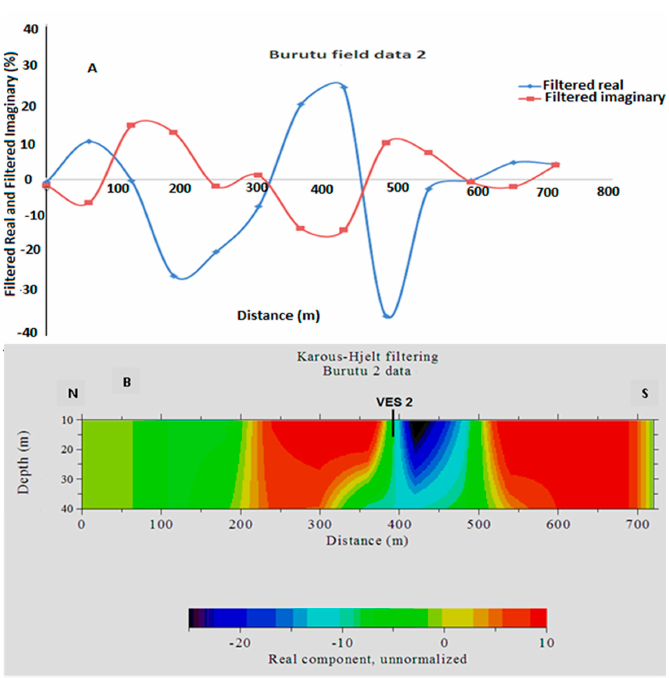
Figure 3. Plot of filtered Real and Imaginary components ( A ) and current density pseudo-section ( B ) for VLF Profile 2.